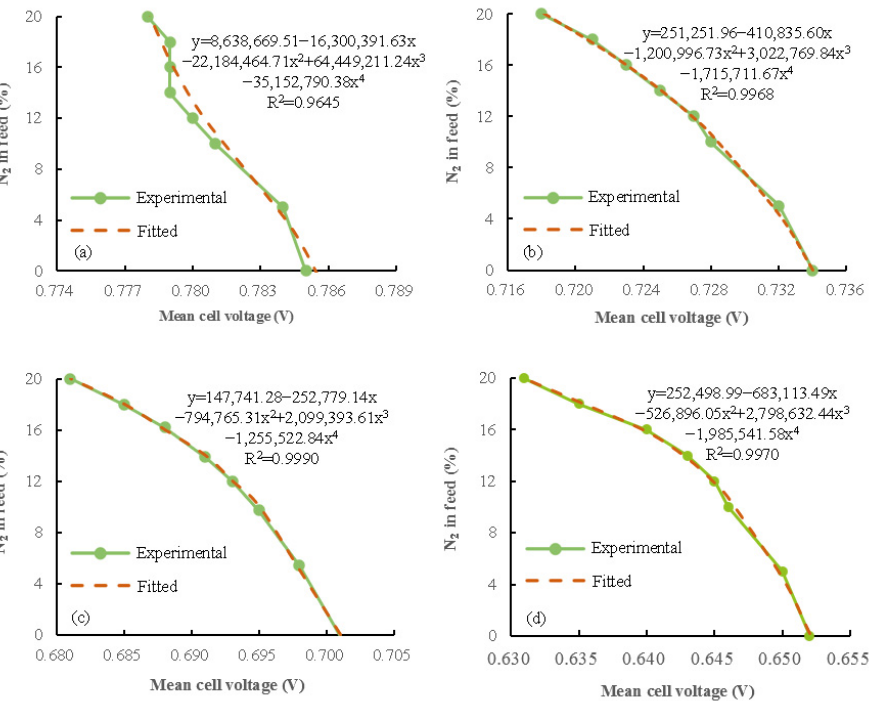
Figure 4. Fitting results of the experiment data at different current densities: ( a ) 0.2 A · cm − 2 ; ( b ) 0.6 A · cm − 2 ; ( c ) 1.0 A · cm − 2 ; ( d ) 1.4 A · cm − 2 .